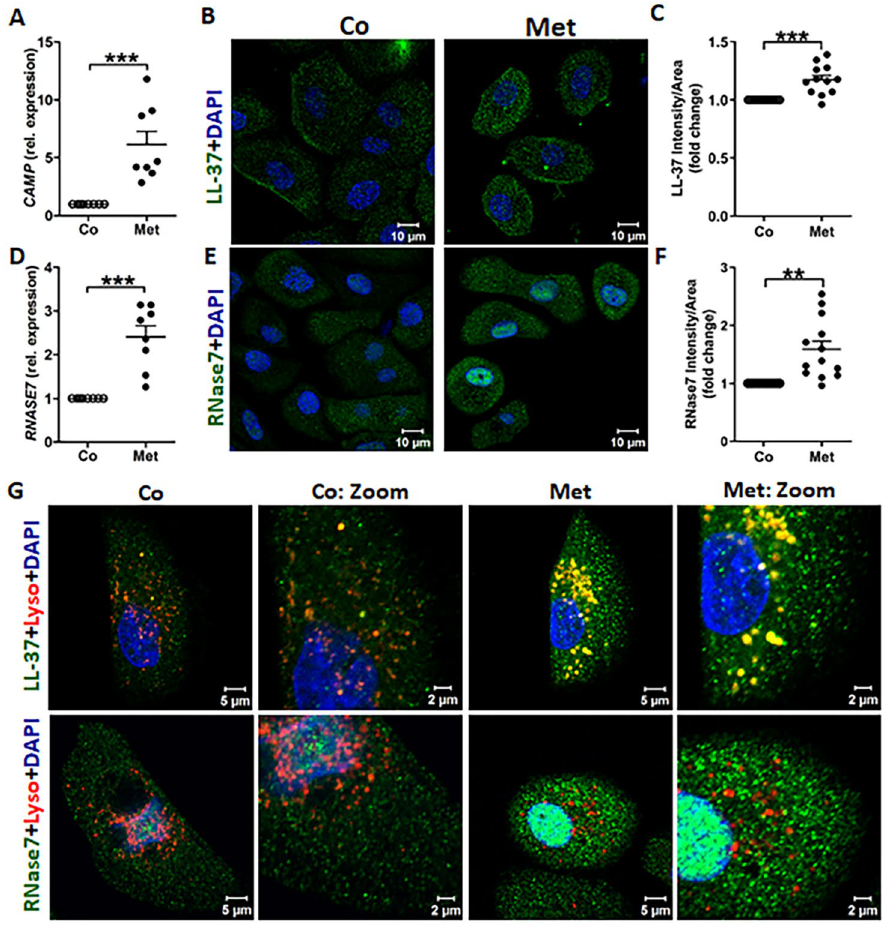
Figure 1. Metformin increases the expression of antimicrobial peptide LL-37 and RNase7 in human uroepithelial cells. ( A ) mRNA expression of CAMP measured using RT-PCR (n = 4, performed in duplicates). ( B ) Representative microscopic images depicting LL-37 stained with Alexa fluor 488 (green), nucleus stained by DAPI (blue) and ( C ) relative average intensity of LL-37 (n = 3, each consisting of 4–5 random view fields). ( D ) mRNA expression of RNASE7 (n = 4, performed in duplicates). ( E ) Representative microscopic images of RNase7 (green) and nucleus (blue). ( F ) Relative average intensity of RNase7 (n = 3, each consisting of 4–5 random view fields). ( G ) Representative microscopic images depicting co-localization of LL-37 (upper panel, green) and RNase7 (lower panel, green) with lysosomes (red) (n = 3). All experiments were performed in human uroepithelial cells, TERT-NHUC and treated with metformin (Met, 4 mM) for either 24 h or 36 h for mRNA and protein respectively, compared to only vehicle treated control. Data are presented as mean with SEM. Significance levels **P < 0.01; ***P <